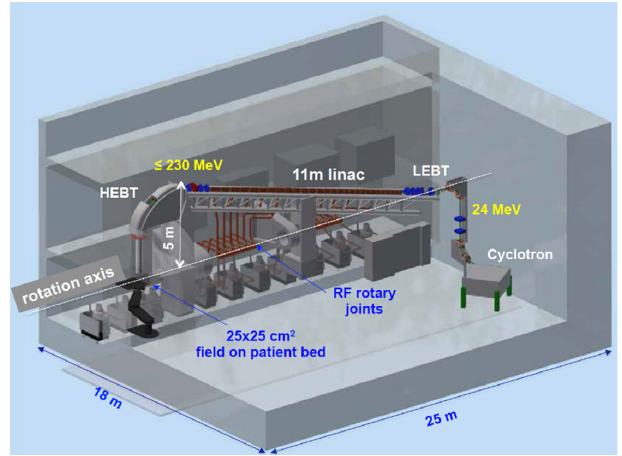
FIG. 1. Layout of the cyclotron and the accelerating structure placed in line with the gantry. The prototype described in this paper can provide guidelines for the design of the last two dipoles placed in the HEBT bending